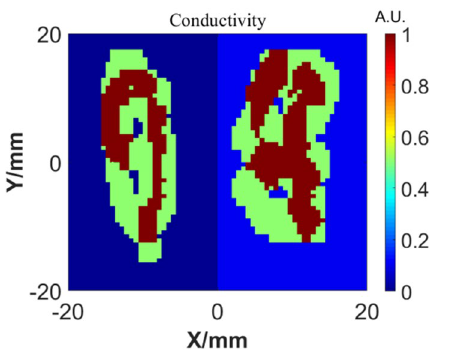
Figure 10. Complex training